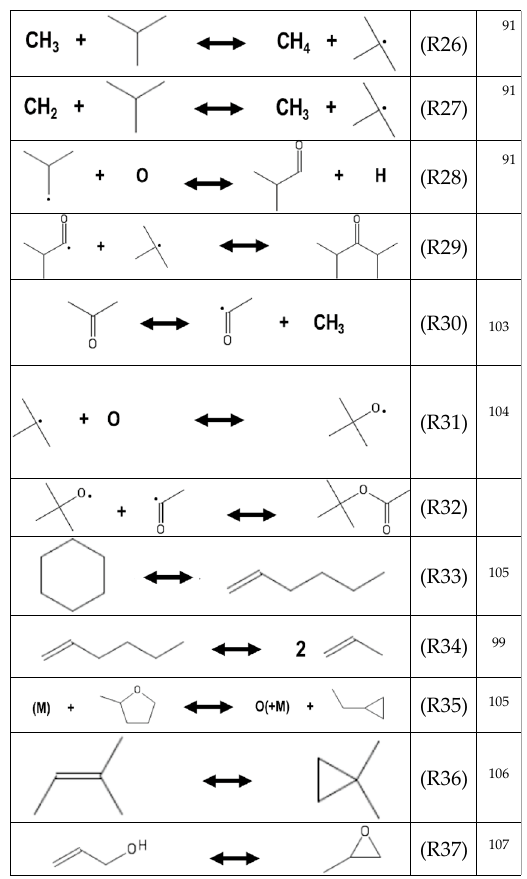
Table 6. Reactions identified that are pertinent to both α- and